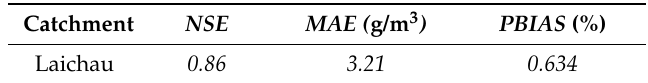
Figure 7. Scatterplot of satellite and simulated monthly basin average LAI.